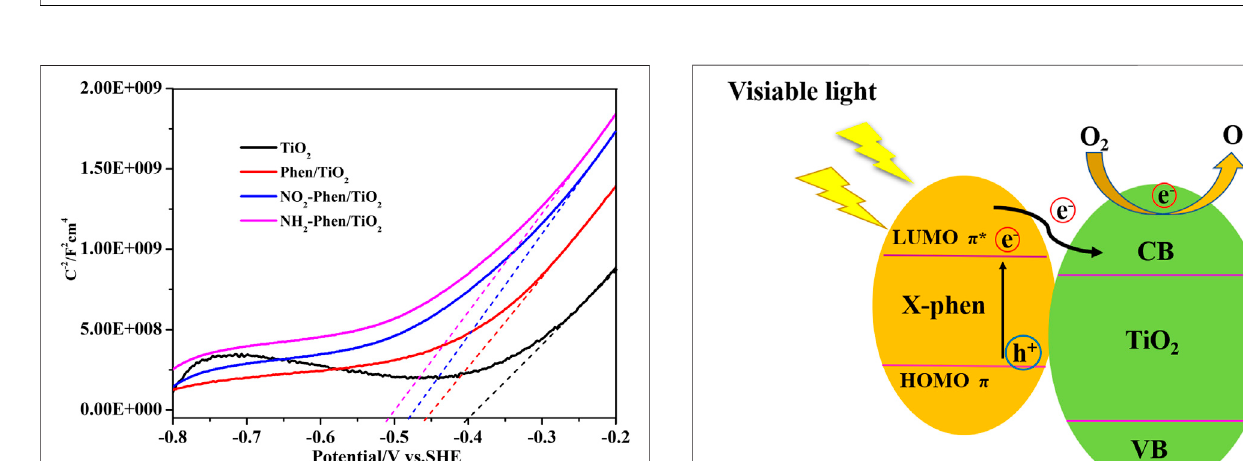
FIGURE 6 | Photoluminescence spectra (A) and electrochemical impedance spectroscopy (B) of NH 2 -Phen/TiO 2 , NO 2 -Phen/TiO 2 , Phen/TiO 2 , and TiO 2 .